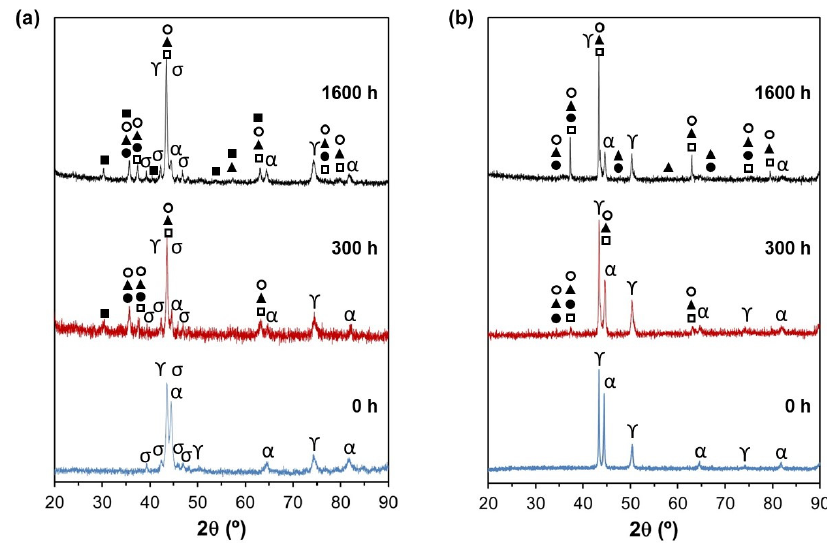
Figure 2. XRD spectra and peak identification chart of oxide scales formed on the surfaces of: ( a ) DS2205 and ( b ) DS2507, after several exposure times to molten salts. The symbols denote the phases: α , δ , γ and σ (of metallic substrate); chromium oxides (e.g., ● FeCr 2 O 4 , and ▲ LiCrO 2 ); iron oxides (e.g., ○ LiFeO 2 and ■ LiFe 5 O 8 ); and □ NiO.